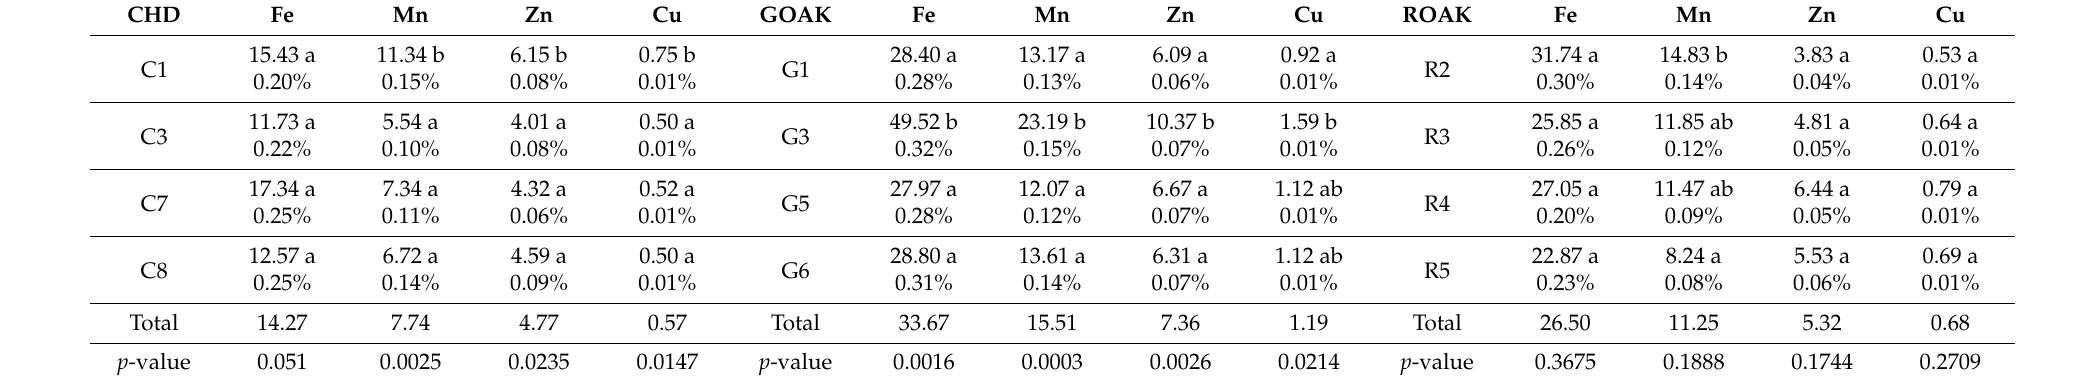
Table 6. Individual analysis of each macronutrient studied in this trial (ppm) at the genotype level for each cultivar. Percentages refer to the proportion of each nutrient in each type of genotype. Data are means of 9 replicates with different letters for each column indicating significant differences ( p -value < 0.01) as determined by LSD multiple comparisons test in the four genotypes analyzed per cultivar ( p